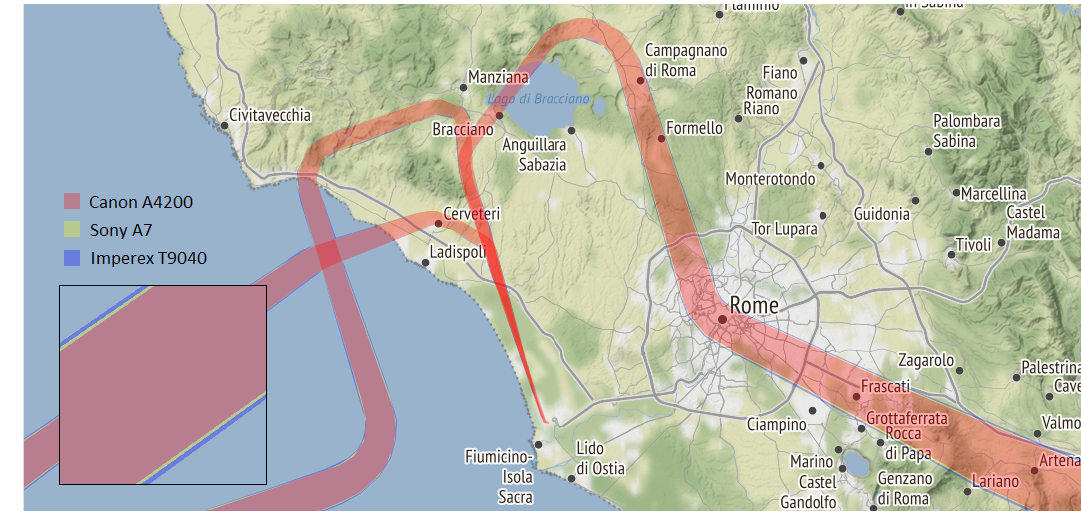
Figure 3. Example of trajectory interpolation and field of view polygons for three aircraft (map tiles by Stamen Design, under CC BY 3.0. Data by OpenStreetMap, under Open Data Commons Open Database